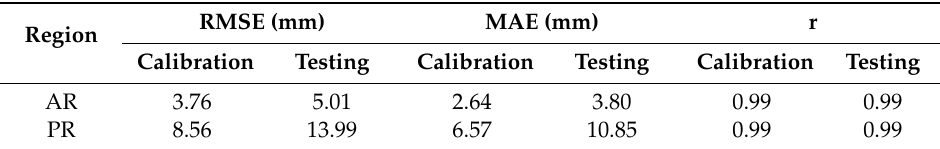
Figure 10. Comparison of the forecasted series with the monthly rainfall anomalies observed during the testing period using the Inverse NLPCA approach. ( a ) Andean region, ( b ) Pacific region.